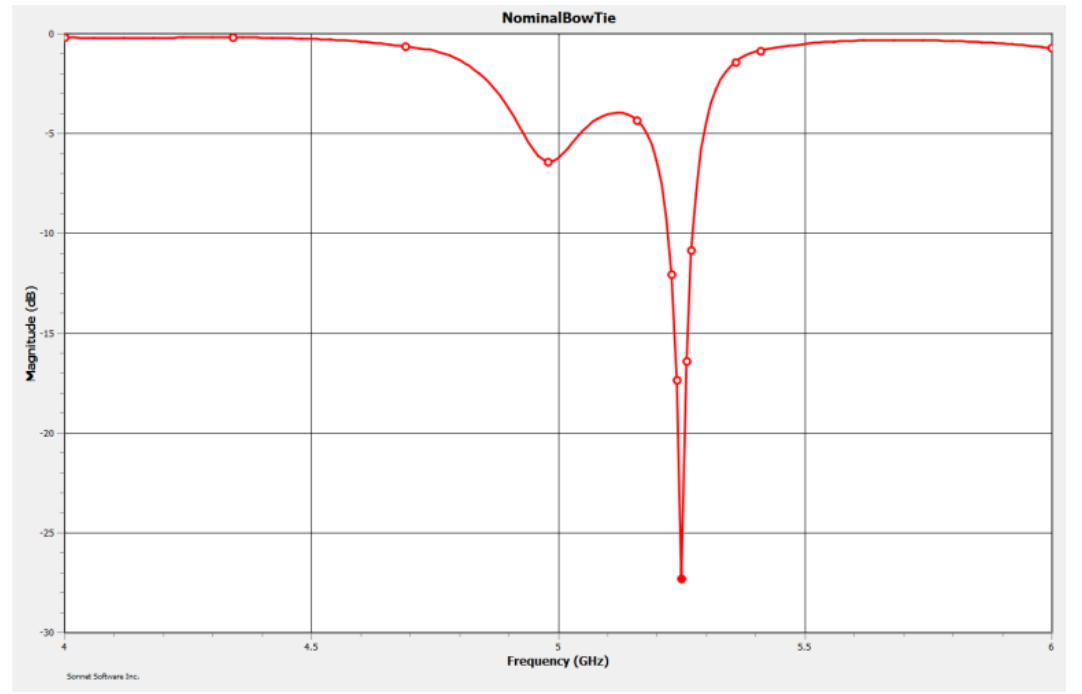
Figure 4. Magnitude/Frequency